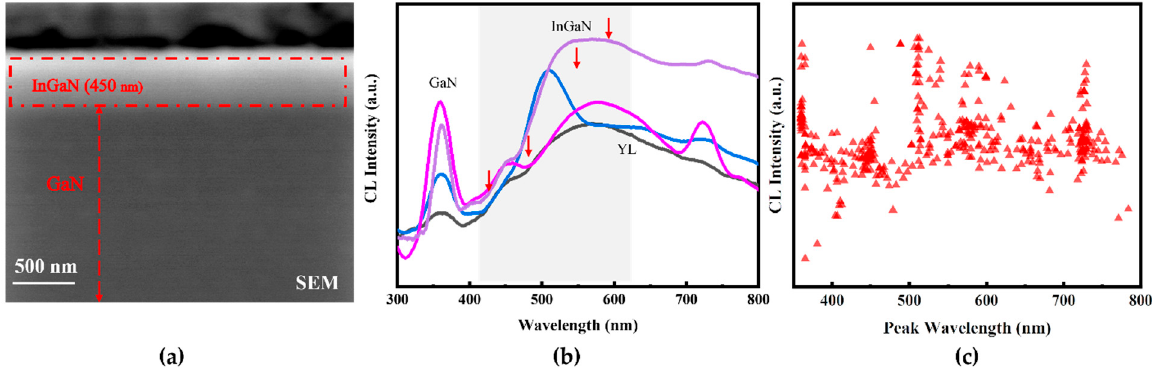
Figure 2. ( a ) Cross-sectional SEM image of the full-composition-graded In x Ga 1 − x N film. ( b ) CL spectra of the full-composition-graded In x Ga 1 − x N film under a beam voltage of 5 kV at room temperature. Four spectra were taken, respectively, from four random regions in the dotted red frame in Figure 2a. The main CL peaks of InGaN have been represented by arrows. ( c ) The wavelength distribution diagram of the CL luminescence peaks of the full-composition-graded In x Ga 1 − x N film under a beam voltage of 5 kV at room